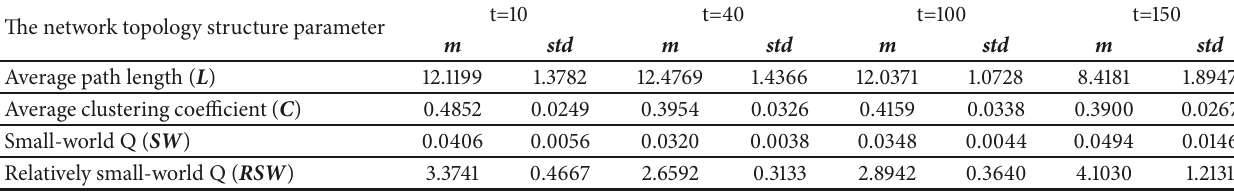
Table 1: The network topology structure parameter values.